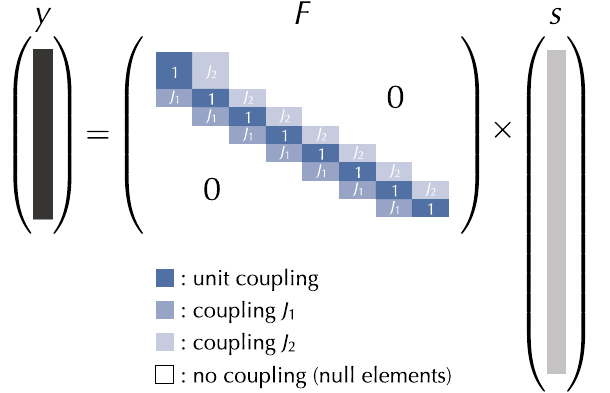
FIG. 5. Evolution of the mean-squared error at different times as a function of the block index for the s-BP algorithm. Exact reconstruction first appears in the left block whose rate (cid:1) (cid:1) allows for seeded nucleation. It then propagates gradu- EM - BP ally block by block, driven by the free-entropy difference be- tween the metastable and equilibrium states. After little more than 300 iterations, the whole signal of density (cid:2) N ¼ 50 000 is exactly reconstructed well inside the zone forbid- den for BP (see Fig. 2). Here, we used L ¼ 20 , J ¼ 1 : 0 , (cid:1) ¼ 0 : 5 0 : 2 , (cid:1) 1